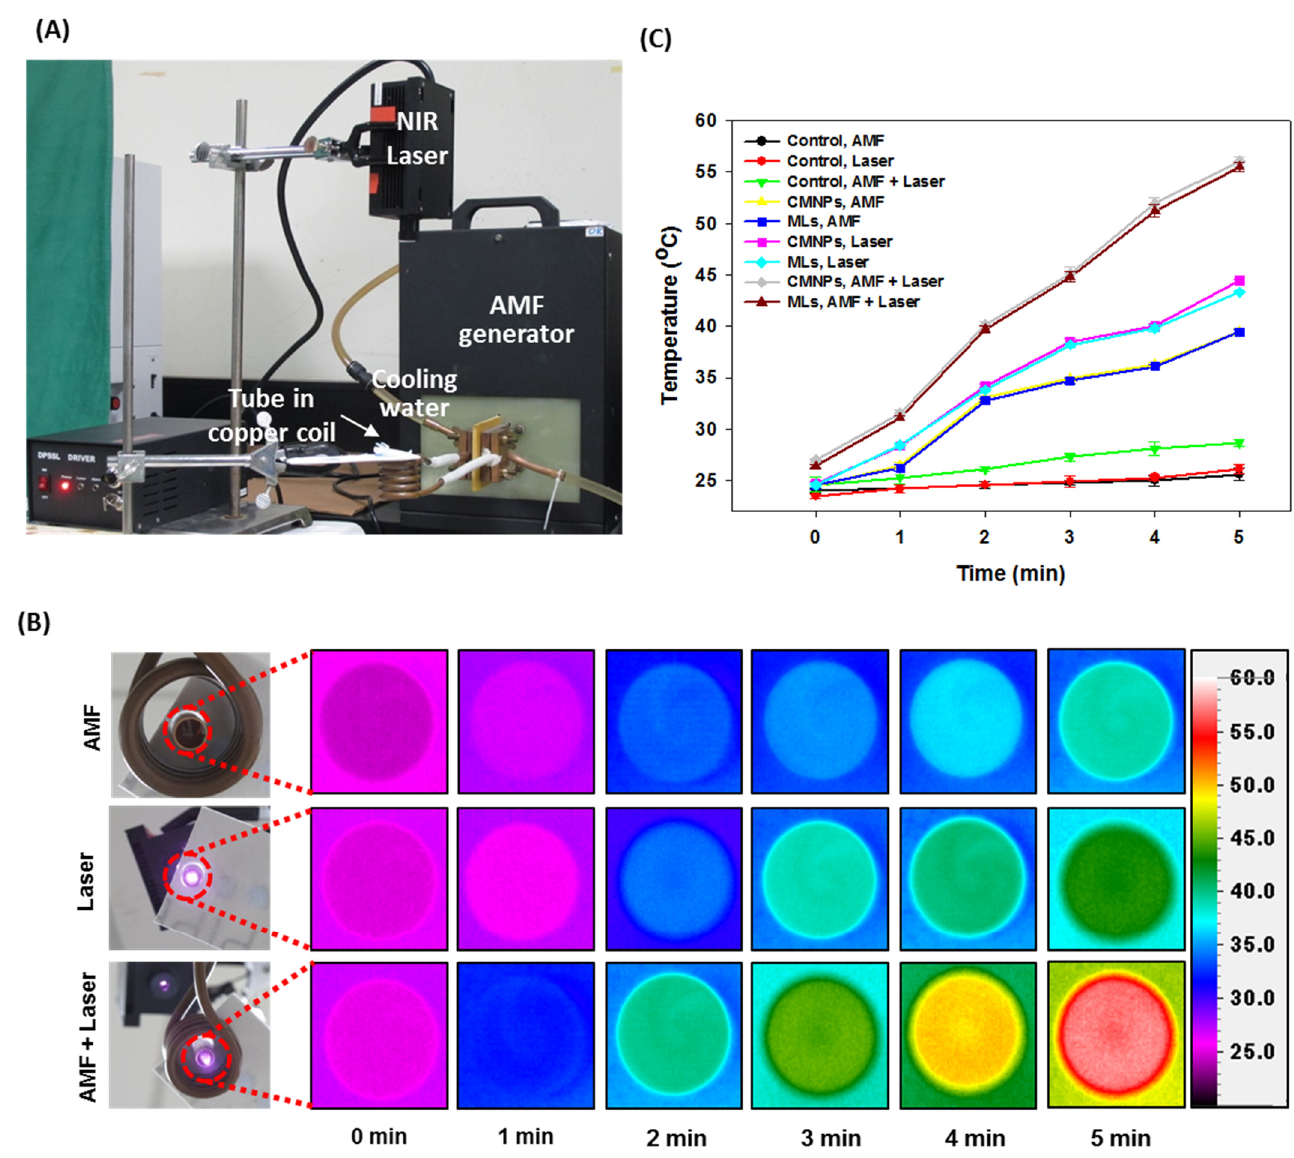
Figure 4. The in vitro heating efficiency of CMNPs and MLs as induced by magnetic hyperthermia–